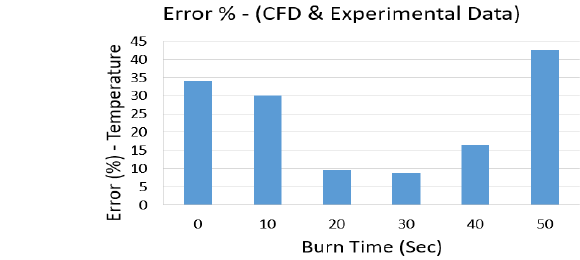
Figure 23. Percentage error between CFD and experimental data.